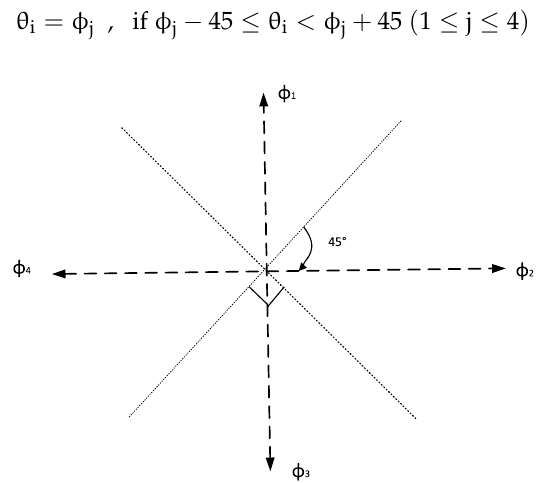
Figure 2. The heading determination graph.